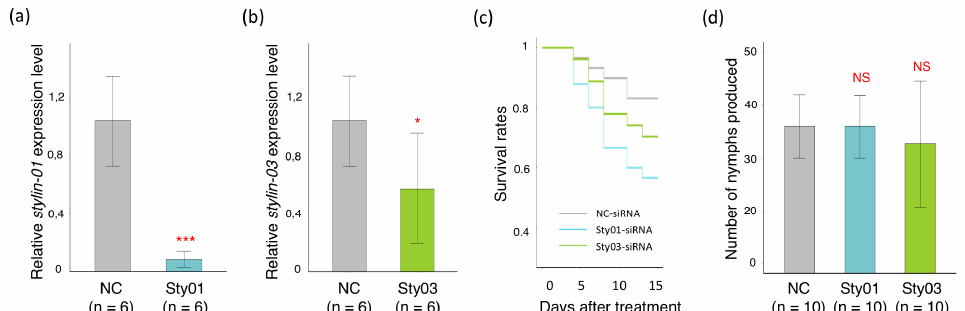
Figure 4. Silencing stylin-01 or stylin-03 in M. persicae has a contrasting impact on aphid fecundity and longevity. The transcript level of stylin-01 ( a ) or stylin-03 ( b ) normalized against two reference genes ( actin and EF1α ). ( a ) The relative expression level of stylin-01 is significantly reduced by 95% in treated Myzus persicae (Sty01) compared with the control aphids (NC) (Welch’s t -test, p = 5.2 × 10 −4 ). ( b ) Identical to Figure 2d, with fecundity and longevity monitored on aphids from the same treated cohorts as the ones used for stylet dissection. The relative expression level of stylin-03 (Sty03) is significantly reduced by 46% compared with the control aphids (Welch’s t -test, p = 0.045). ( c ) Survival curves of treated aphids. The different lines represent the survival curves for the three groups of aphids. The results are reported as means (initial n = 30, 25 and 27 aphids for NC, Sty01 and Sty03 groups, respectively). ( d ) A number of nymphs are produced for each condition. Data shown are means (± standard deviation) of total number of nymphs produced over 15 days per apterous adult ( n = 10). No significant difference was observed between the three groups (ANOVA, 0.45 < p < 1). Asterisks in panels A and B indicate statistically significant differences as follows: ***, p < 0.001; *, p < 0.05. NS—not significant.